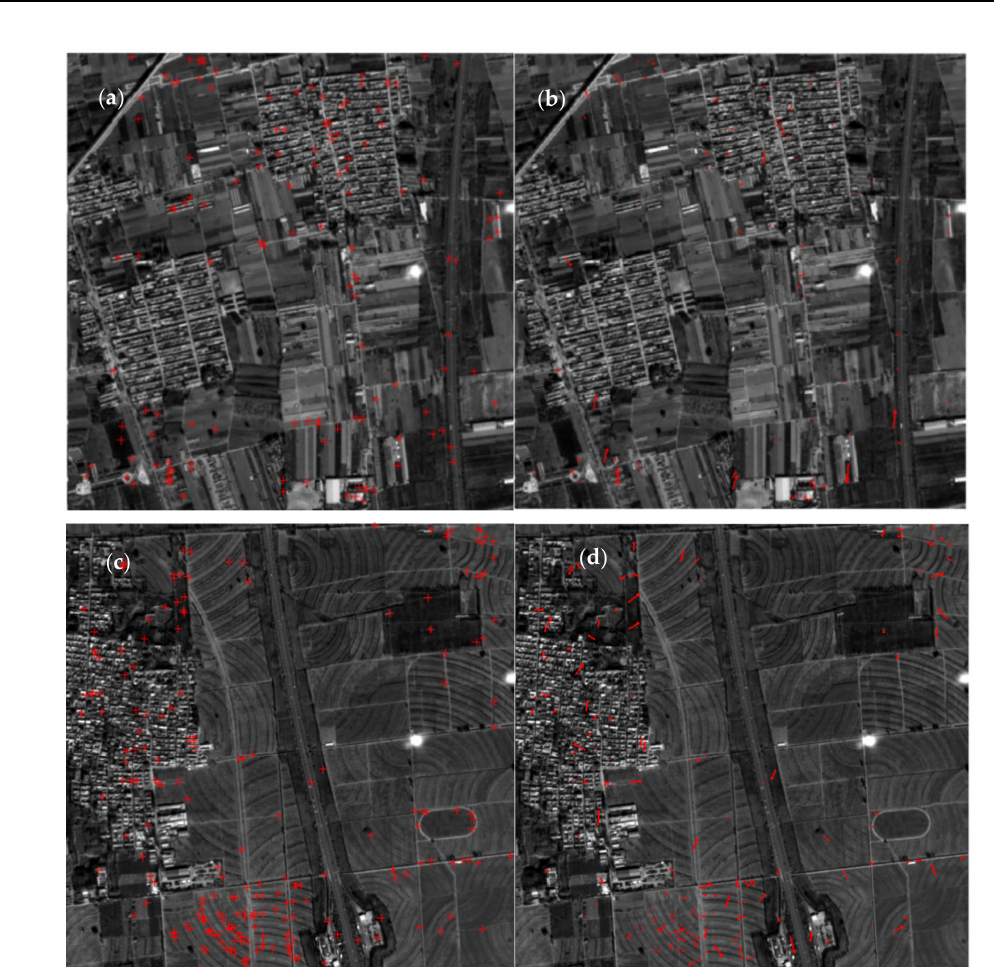
Figure 9. LPM-SIFT matching results. ( a ) 142 original matches on image 717. ( b ) Residual distribution of image 717 after mismatch removal (10 × magnification). ( c ) 223 original matches on image 723. ( d ) Residual distribution of image 223 after mismatch removal (10 ×